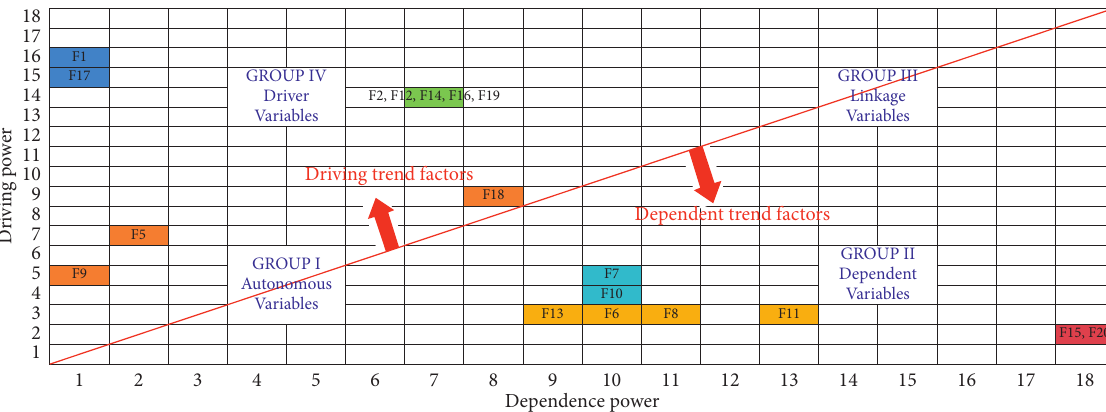
Figure 8: Results of MICMAC analysis of influence